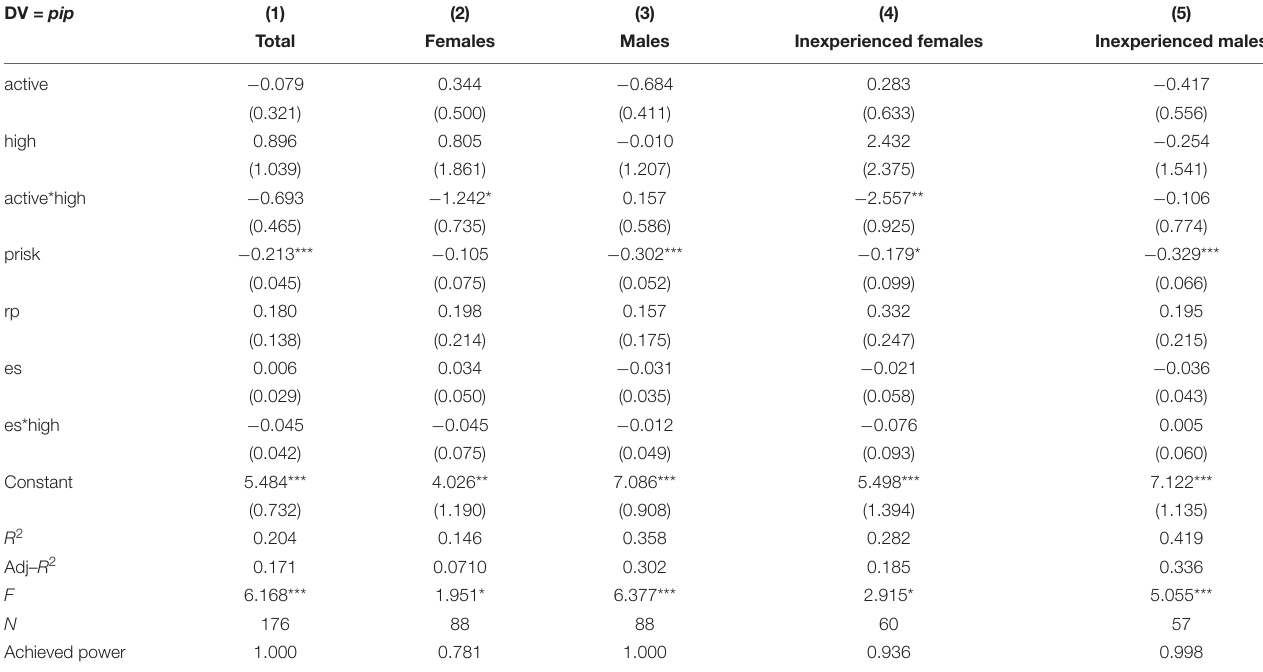
TABLE 1 | OLS regressions on the effects of